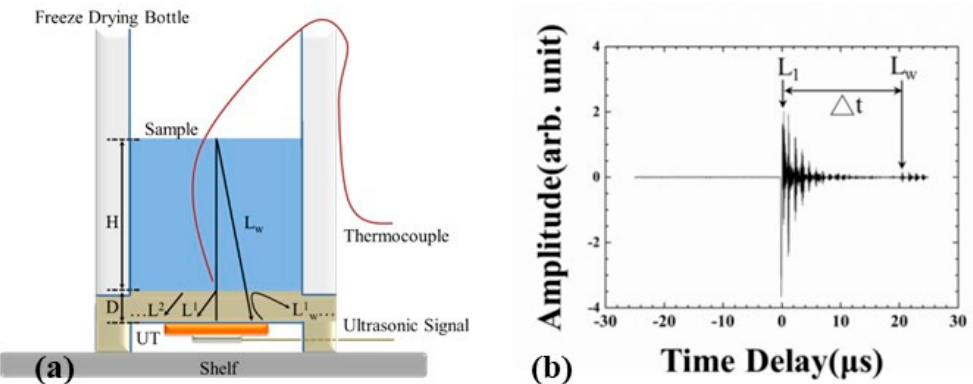
Figure 3. ( a ) Schematic drawing of cross-section of the designed apparatus with an ultrasonic transducer (UT) and thermocouple and ( b ) shows the typical ultrasonic echoes acquired by the